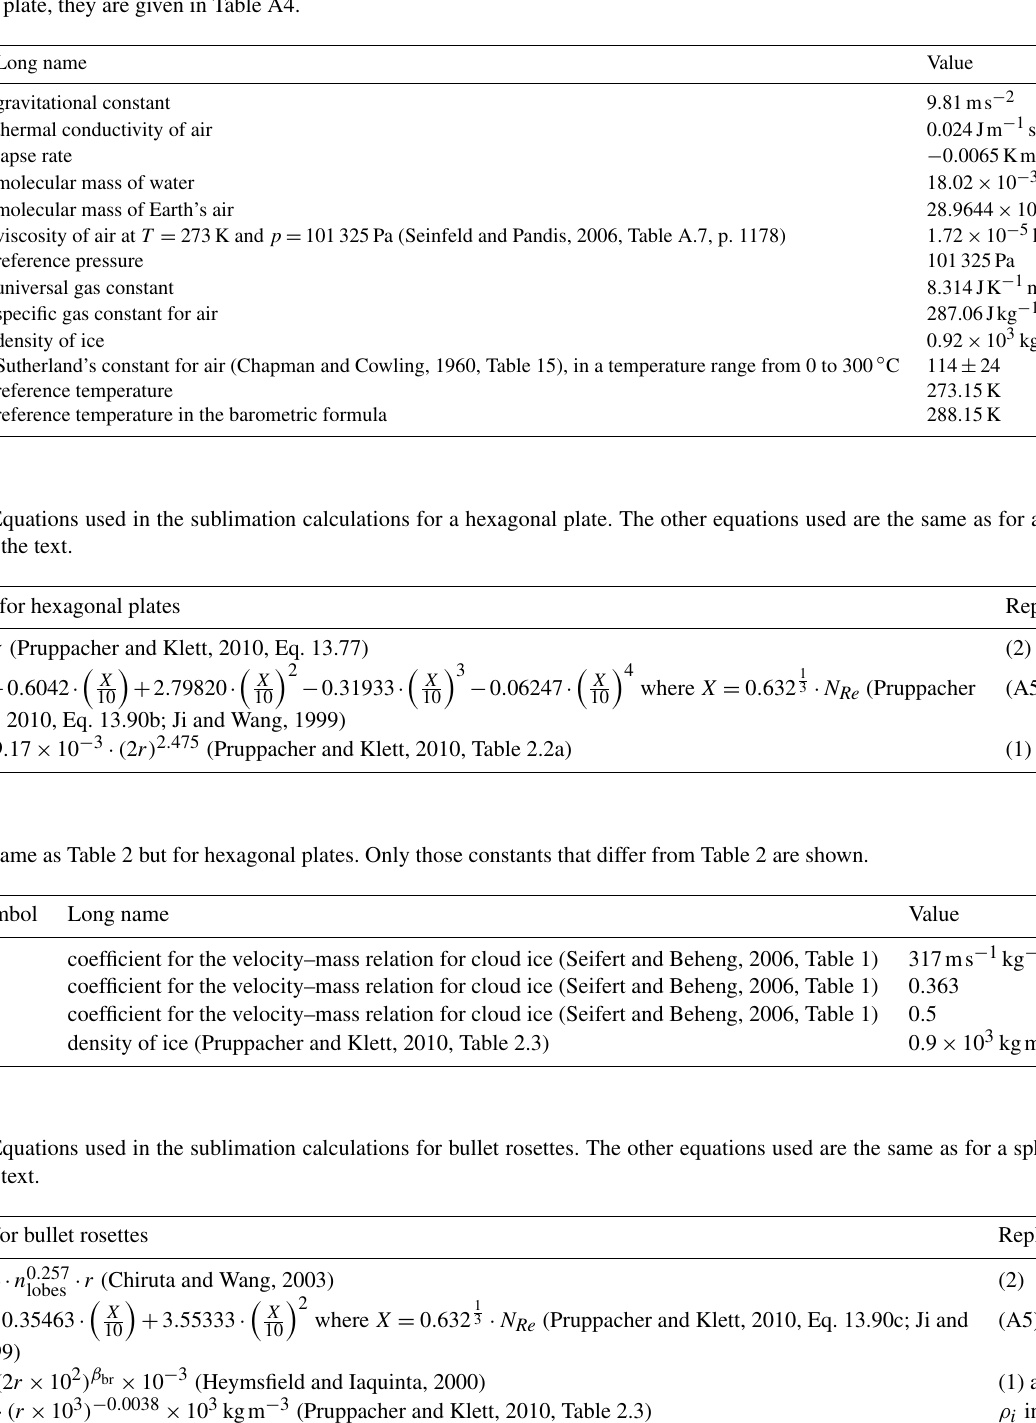
Table A2. Constants used in the sublimation calculations for a sphere (addition to Table 2). Note that the parameterization for the velocity– mass relation for cloud droplets from Seifert and Beheng (2006) is used for spherical ice crystals here. Where the constants are different for a hexagonal plate, they are given in Table A4.